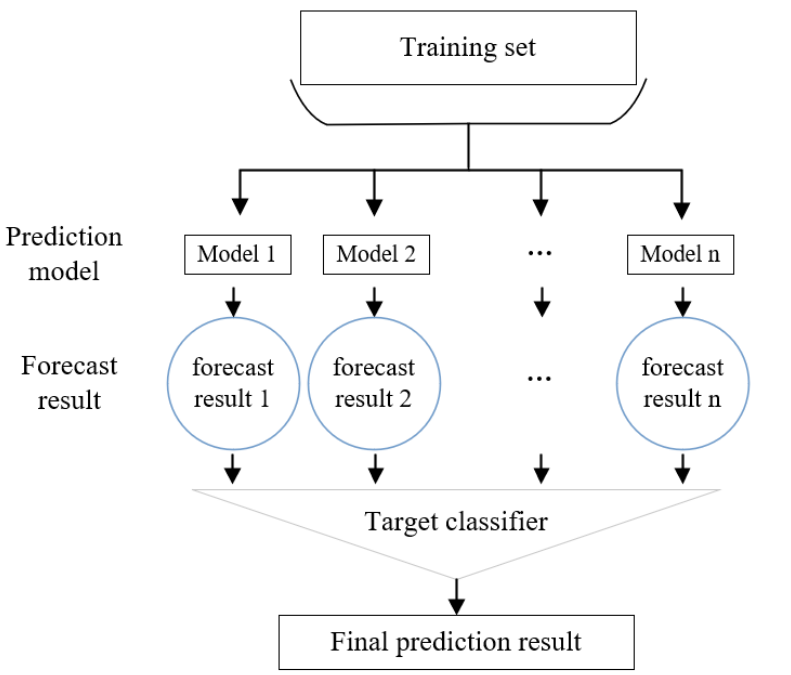
Figure 3. Stacking algorithm implementation form.